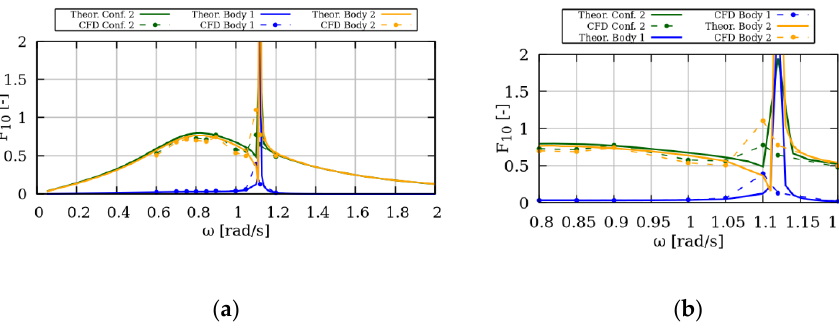
Figure 11. Comparison between the theoretical and CFD results of the non ‐ dimensional horizontal excitation force, in case of the Configuration 2; ( a ) wave frequencies 0.05 and 2 rad/s; ( b ) wave frequencies between 0.8 and 1.2 rad/s (detailed view).